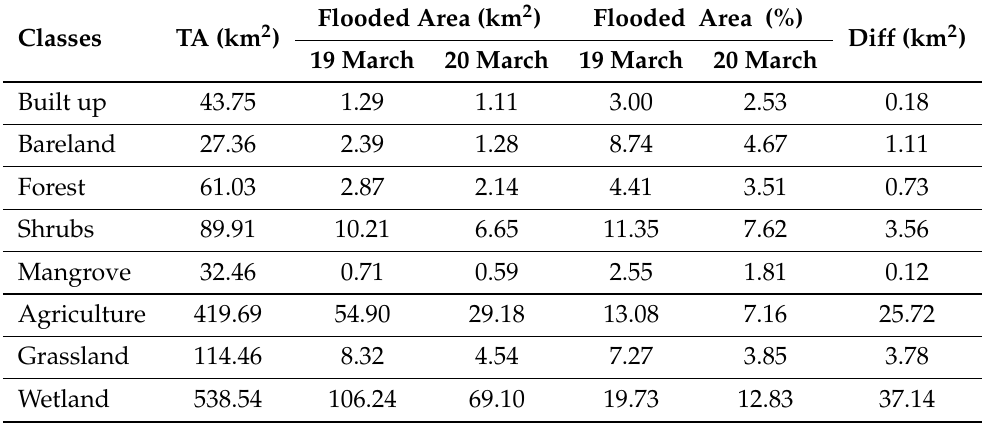
Table 7. Flooded areas in km 2 on 19 and 20 March 2019 and the percentages of flooded areas for each LC in Beira. TA and Diff stand for total area and difference flooded areas on 19 and 20 March,